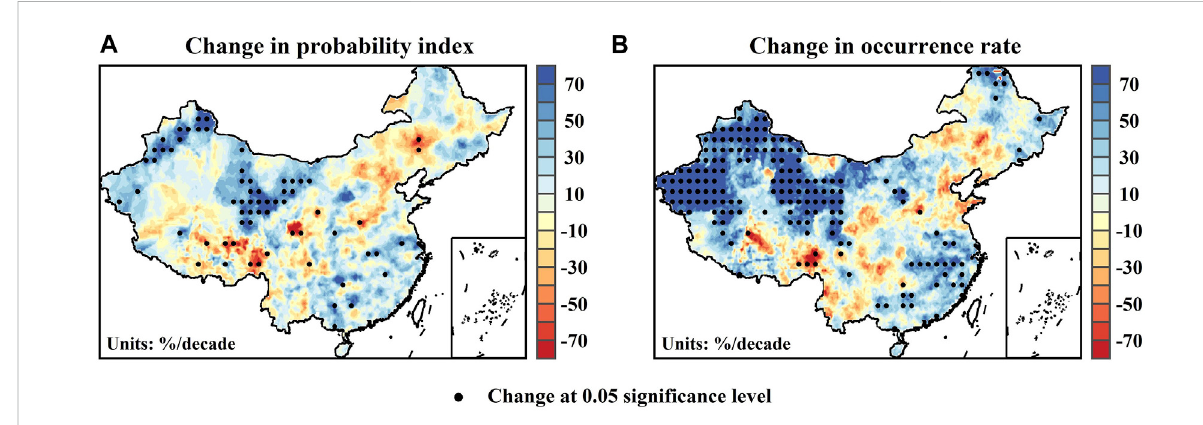
FIGURE 4 Changes in probability index (A) and occurrence rate (B) during 1961 – 2018 over China. The probability index is estimated based on the GEV distribution and the occurrence rate is estimated based on the Poisson distribution (see Section 3). The black dots indicate the change at 0.05 signi fi cance